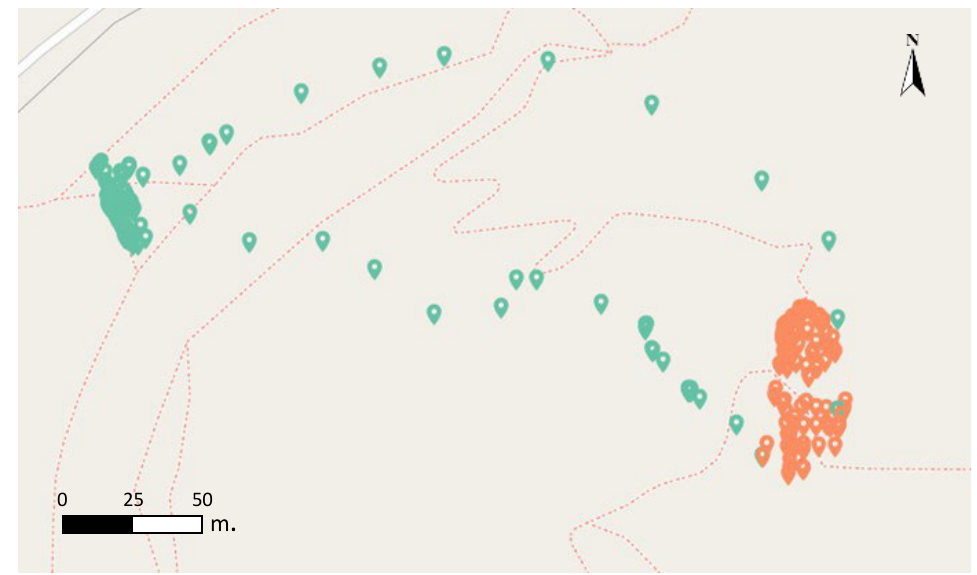
Figure 15. Recording segments of a trajectory (with orange color). Intersecting trajectories are displayed (Figure 16) on a map report by executing a Cypher query (Appendix B.5).